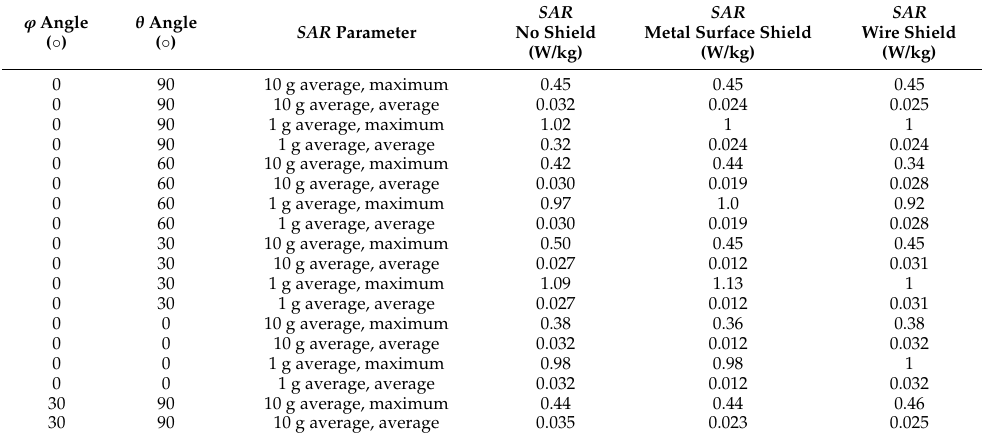
Table A3. SAR parameters for 3600 MHz and all combinations of ϕ and θ angles